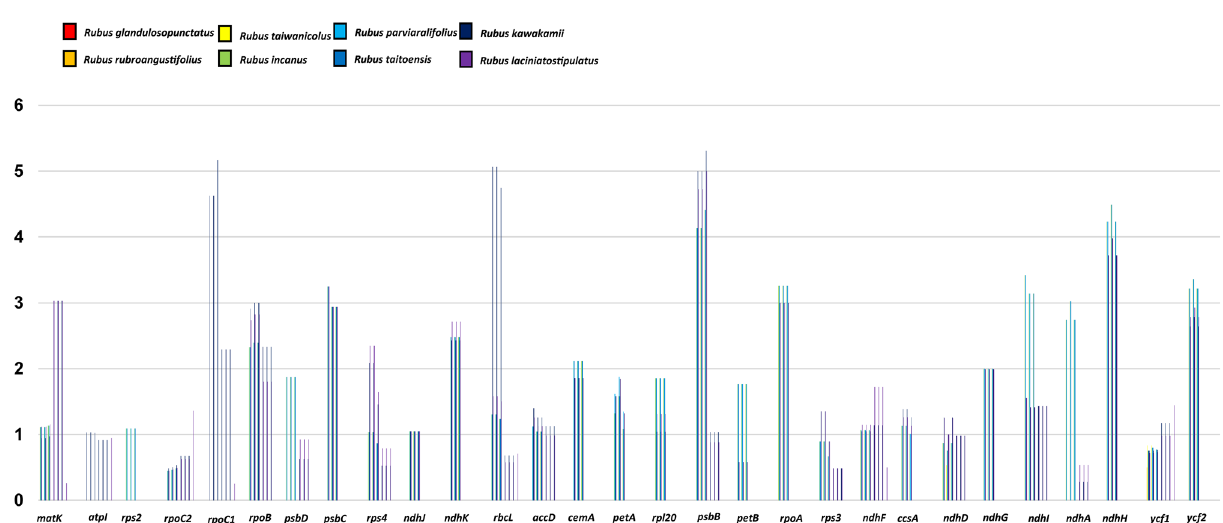
Figure 6. The Ka/Ks ratio of 73 protein-coding genes of cp genomes from eight endemic whole chloroplast genomes of Rubus species in Taiwan. X-axis: Ka/Ks ratio, Y-axis: 29 protein-coding genes with the Ka/Ks ratio of >